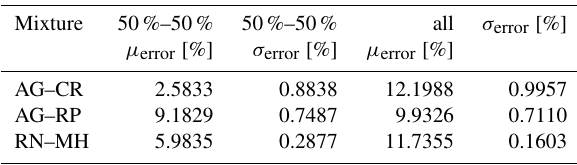
Table 1. Quantitative evaluation of de-mixing errors (biases) ob- tained using synthetic (simulated)